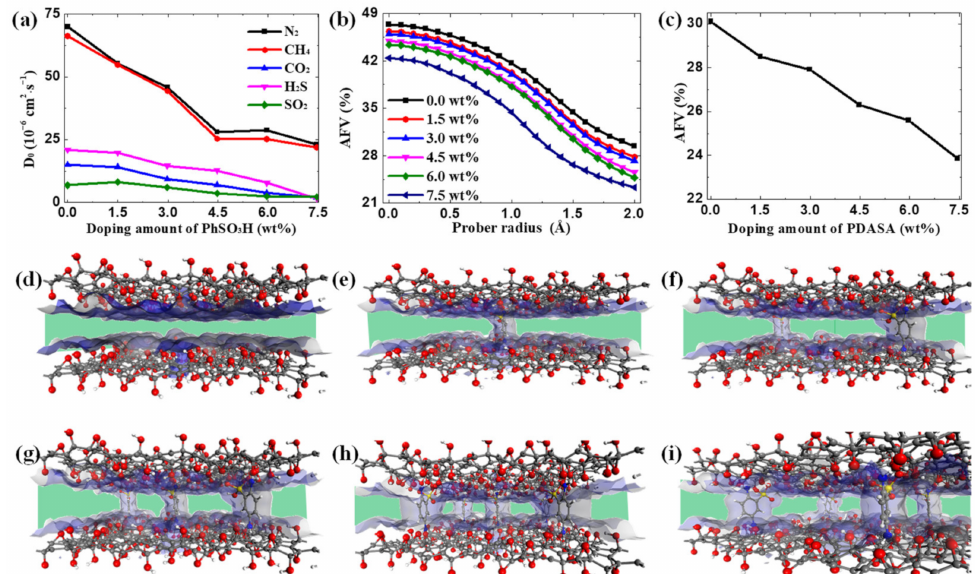
Figure 6. Diffusion insights. ( a ) Diffusion coefficient of different gases. ( b ) The free accessible volume of variable GO membranes. ( c ) The detected AFV with a 1.9 Å-sized prober is dependent on the doping amount of PDASA. Visualization of passage in variable GO channels. ( d ) 0.0 wt%. ( e ) 1.5 wt%. ( f ) 3.0 wt%; ( g ) 4.5 wt%; ( h ) 6.0 wt%; ( i ) 7.5